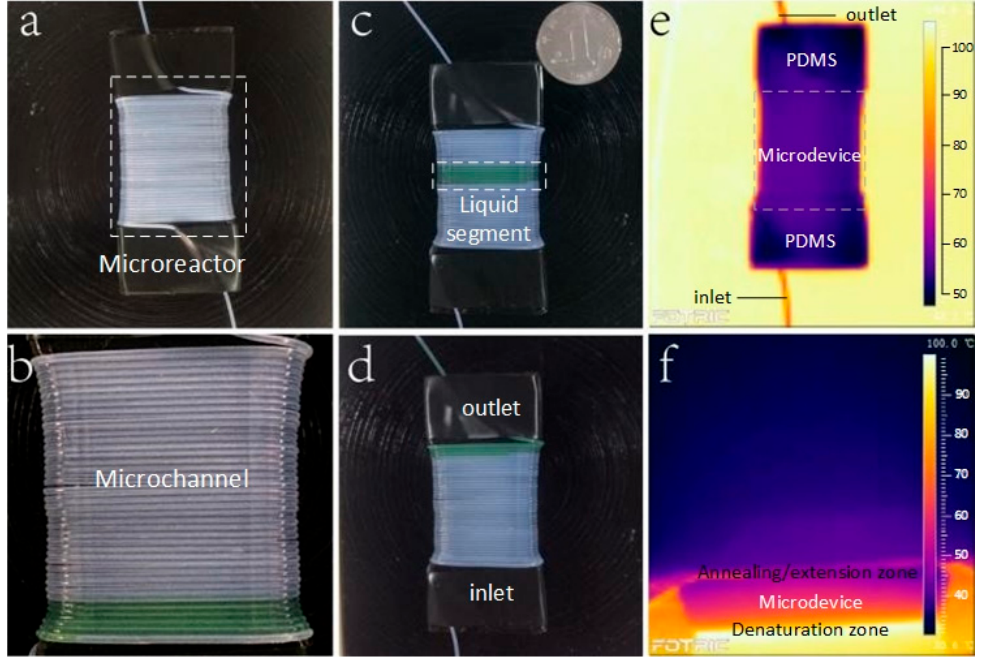
Figure 2. The set-up for plug-based continuous-flow on-chip PCR ( a ) with the green-color sample flowing at the start ( b ), the middle ( c ), and the end ( d ) of the fluidic conduit. ( e ) The top view and ( f ) the side view of the thermal infrared image of the trapezoidal PDMS block.